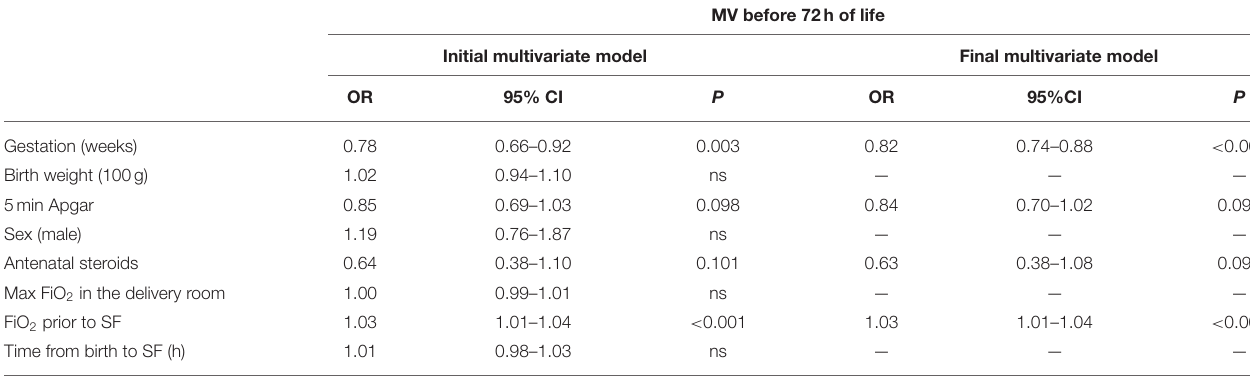
TABLE 2 | Logistic regression analysis examining the prediction failure of LISA combined with CPAP.